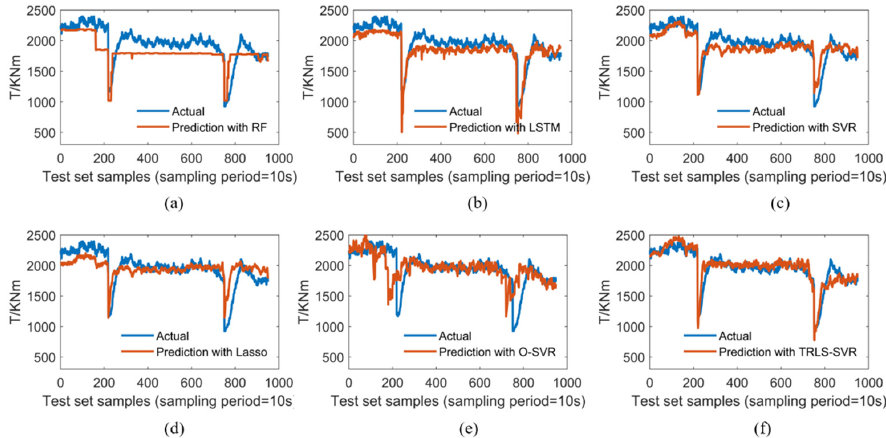
Figure 5. Comparisons between real and predicted cutterhead torque for dataset 1. ( a ) Prediction result of RF. ( b ) Prediction result of LSTM. ( c ) Prediction result of SVR. ( d ) Prediction result of Lasso. ( e ) Prediction result of OSVR. ( f ) Prediction result of TRLS-SVR.